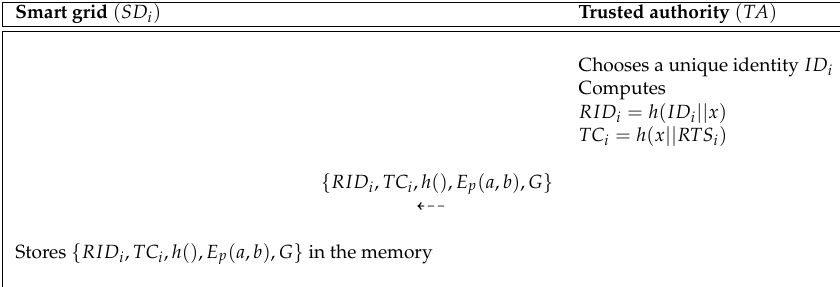
Figure 3. Smart grid device registration process of Kumar et al.’s